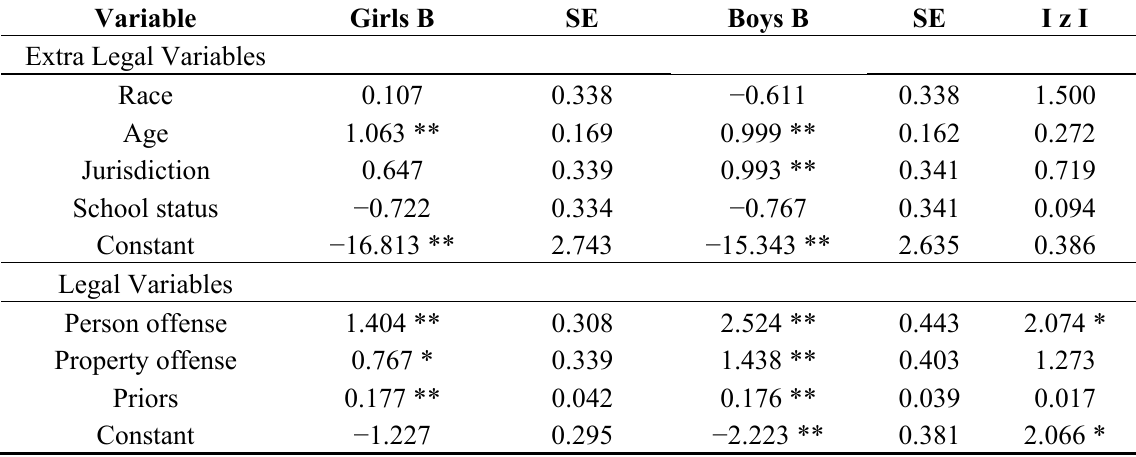
Table 5. Analysis of Extra Legal and Legal Variables for Girls and Boys ( N = 230 Girls and N = 230